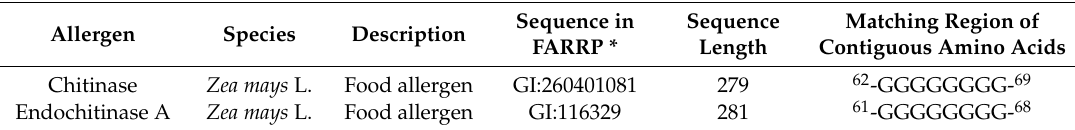
Sequence in Sequence Matching Region of FARRP * Length Contiguous Amino Acids